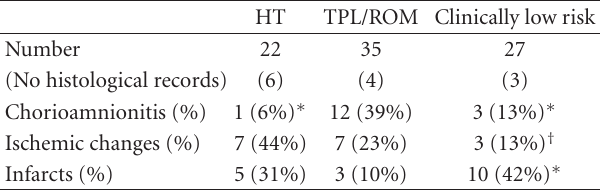
Table 4: The histological study of women complicated with placental abruption among groups of HT, TPL/ROM, and clinically low risk. HT TPL/ROM Clinically low risk Number 22